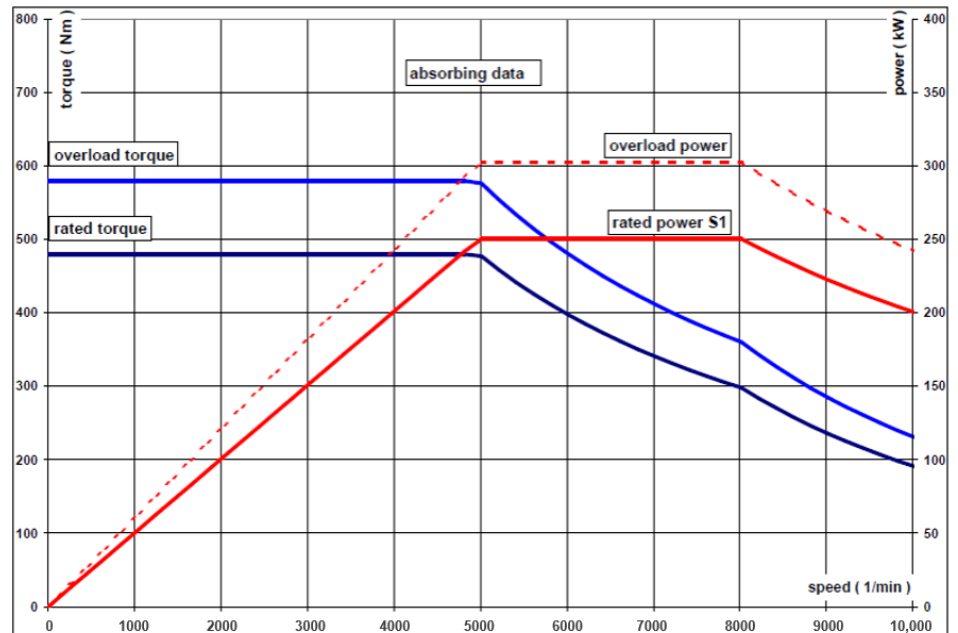
Figure A2. The performance plot from Horiba DYNAS3 LI250 (Source: Horiba).